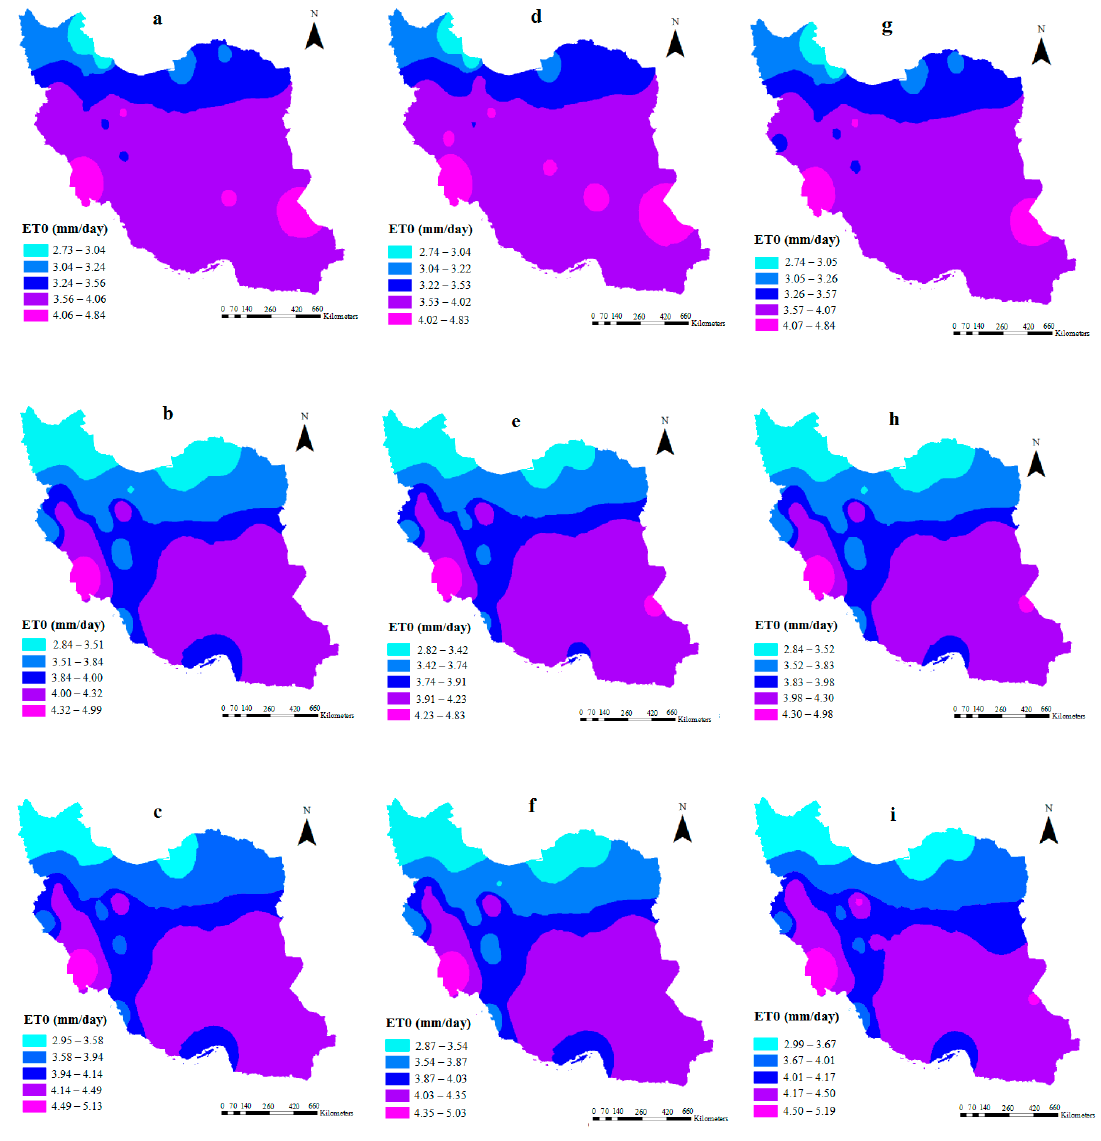
Figure 4. The spatial distribution of the ET 0 predicted from 2011 to 2113 under di ff erent scenarios. ( a = 2011–2045-A1B, b = 2046–2079-A1B, c = 2080–2113-A1B, d = 2011–2045-B1, e = 2046–2079-B1, f = 2080–2113-B1, g = 2011–2045-A2, h = 2046–2079-A2, i = 2080–2113-A2).